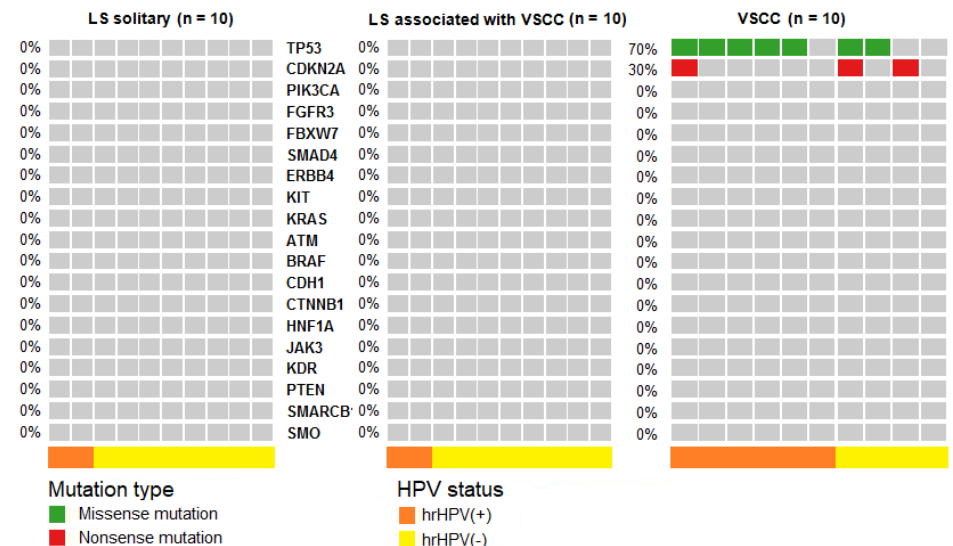
Figure 3. Distribution of pathogenic mutations in solitary lichen sclerosus (LS) (n = 10) and LS (n = 10) associated with VSCC (n = 10). Each column corresponds to an individual LS or VSCC case, while each row corresponds to the mutated gene. Samples with no mutations detected are depicted in grey, missense mutations are highlighted in green, whereas red hits indicate nonsense mutations. hrHPV-positive and hrHPV-negative samples are marked in the bottom line with orange and yellow color, respectively.